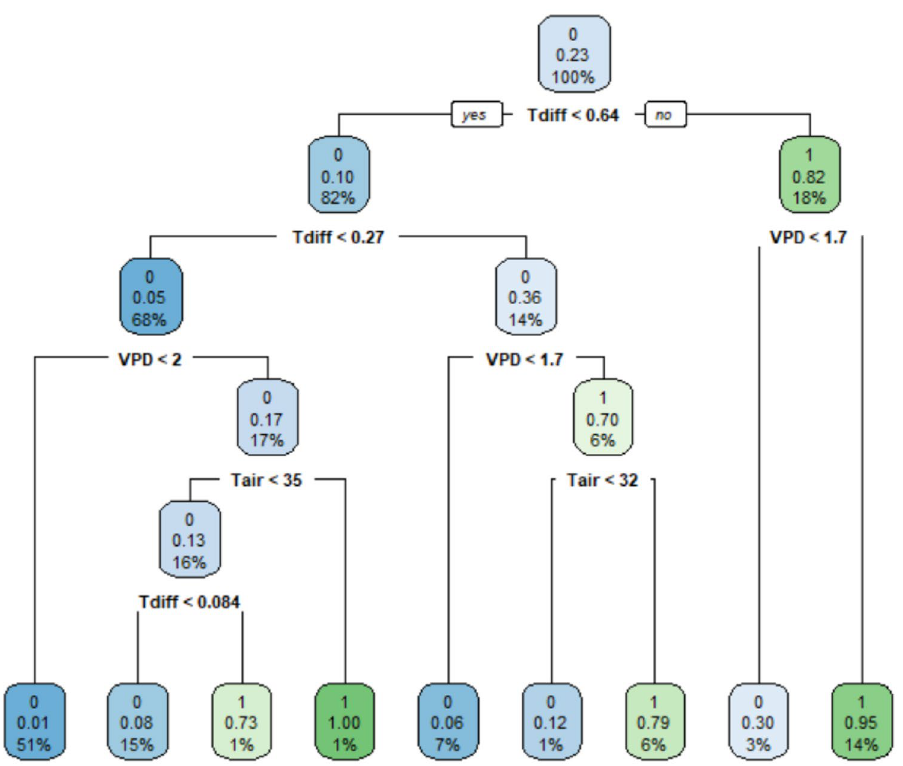
Figure 2. Classification and regression tree model for classifying binary drought status. At each intermediate node, a case goes to the left child node only if the condition is satisfied. Each node in the model has three values, the top value is the predicted class at this node, the second value is the probability that the Y = 1 (water deficit stress), and the third value is the number of observations for this node as a percentage of the whole dataset. The predicted class is a (0,1) variable, where 0 represents well-watered and 1 represents water deficit stress,